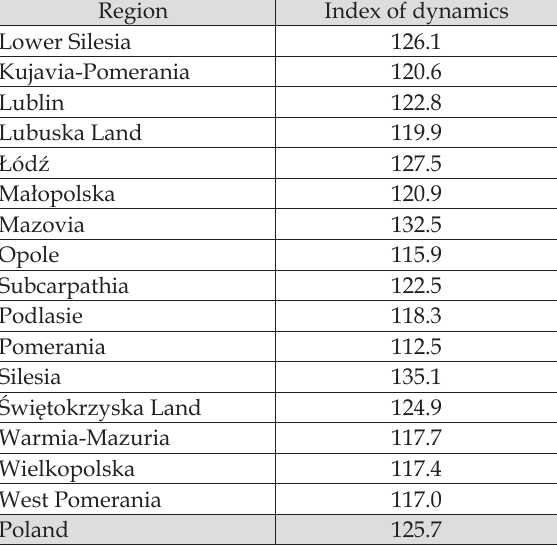
Table 4. Dynamics of per capita GDP by region